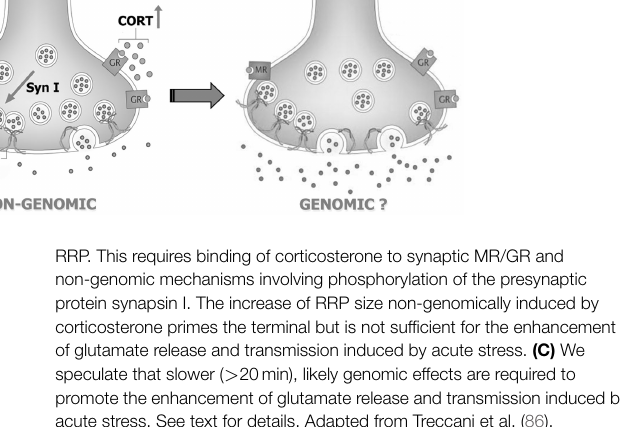
FIGURE 1 | Acute stress and corticosterone rapidly increase the readily releasable pool of glutamate vesicles in prefrontal and frontal cortex synaptic terminals through non-genomic mechanisms . (A) PFC glutamate synaptic terminal in basal conditions, showing the readily releasable pool (RRP) of vesicles anchored to the membrane and ready for release and membrane-located mineralocorticoid and glucocorticoid receptors (MR and GR, respectively). (B) The rise of corticosterone (CORT) induced by acute stress causes a rapid increase of vesicle trafficking into the